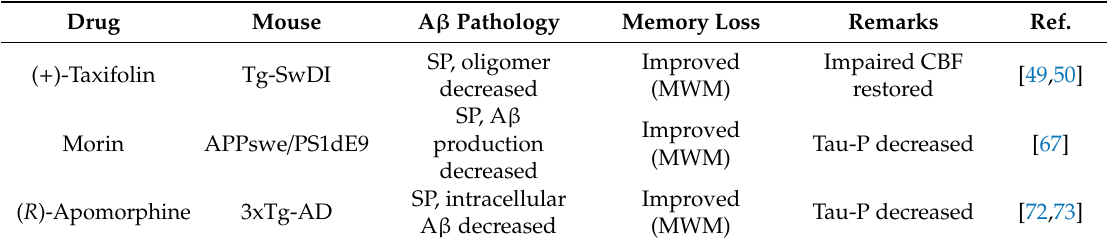
Table 1. Preclinical studies of compounds in this review using Alzheimer’s disease (AD) model mice. Drug Mouse A β Pathology Memory Loss Remarks